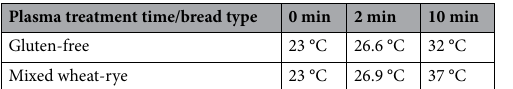
Table 1. Temperature of bread samples before and after plasma treatment.